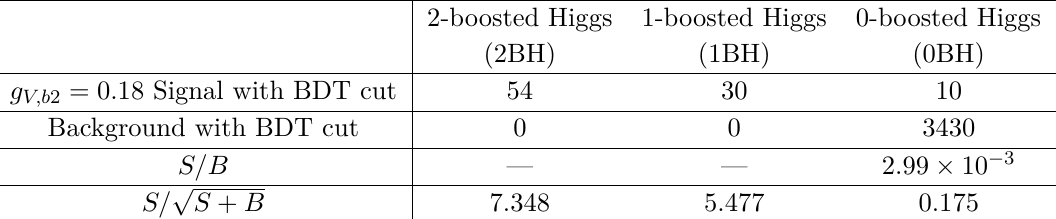
Table 11 . The significances of the BDT at 14 TeV collider are